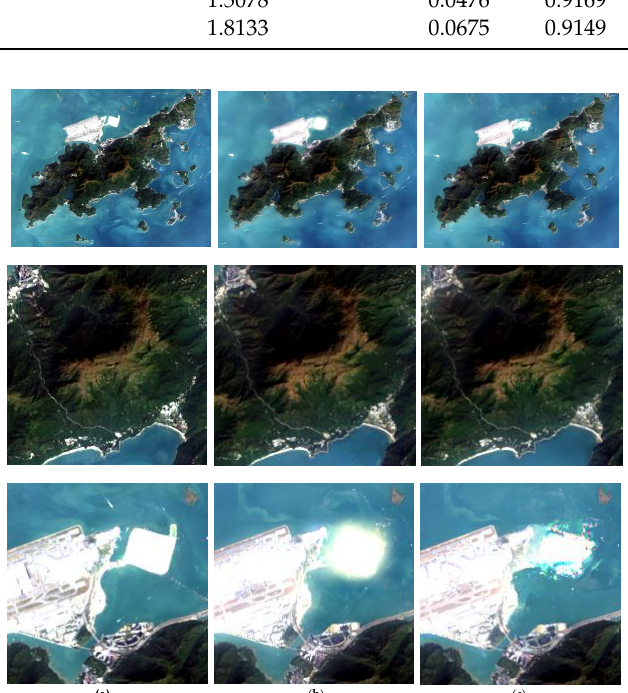
Figure 7. Fusion results for Lantau Island and the Hong Kong International Airport on 18 October 2015, zoomed to the unchanged vegetation area (images in the 2nd row) and the newly built artificial island (images in the 3rd row). ( a ) Landsat 8 at 30 m; ( b ) fused image at 30 m by HNN-SPOT; ( c ) fused image at 30 m by STARFM.